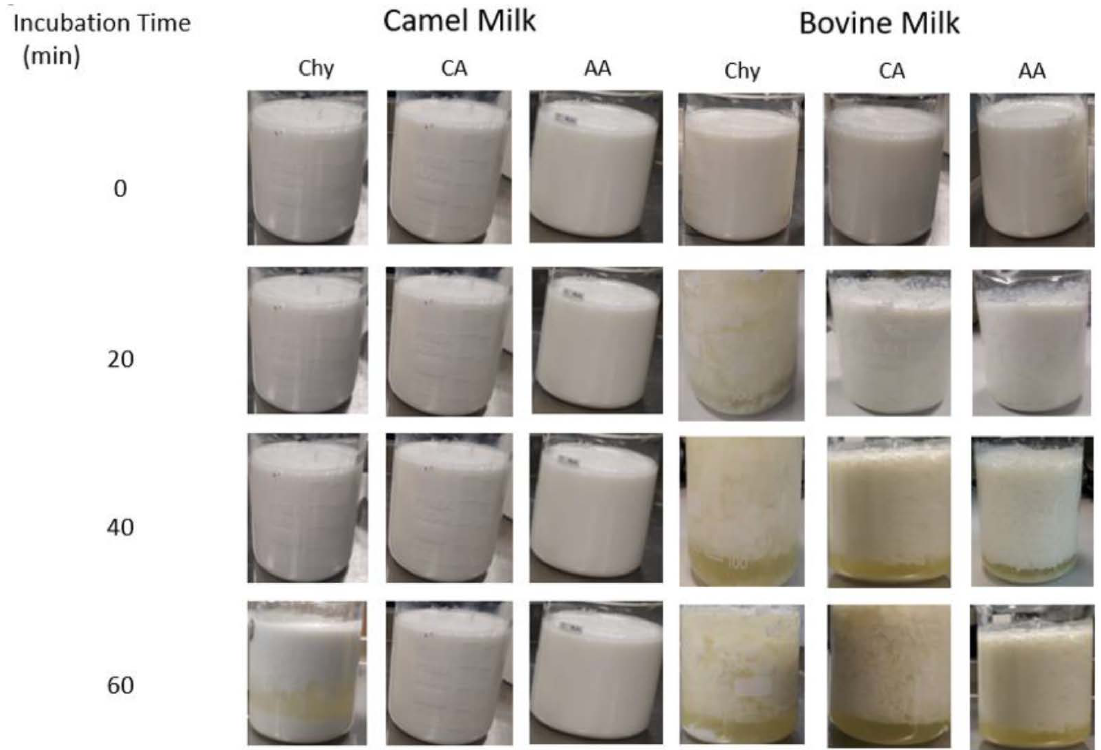
Figure 8. Photographed images of coagulation behaviors with time (0–60 min). Chy (chymosin), CA (citric acid), AA (acetic acid). Source: [104] Reproduced with permission from